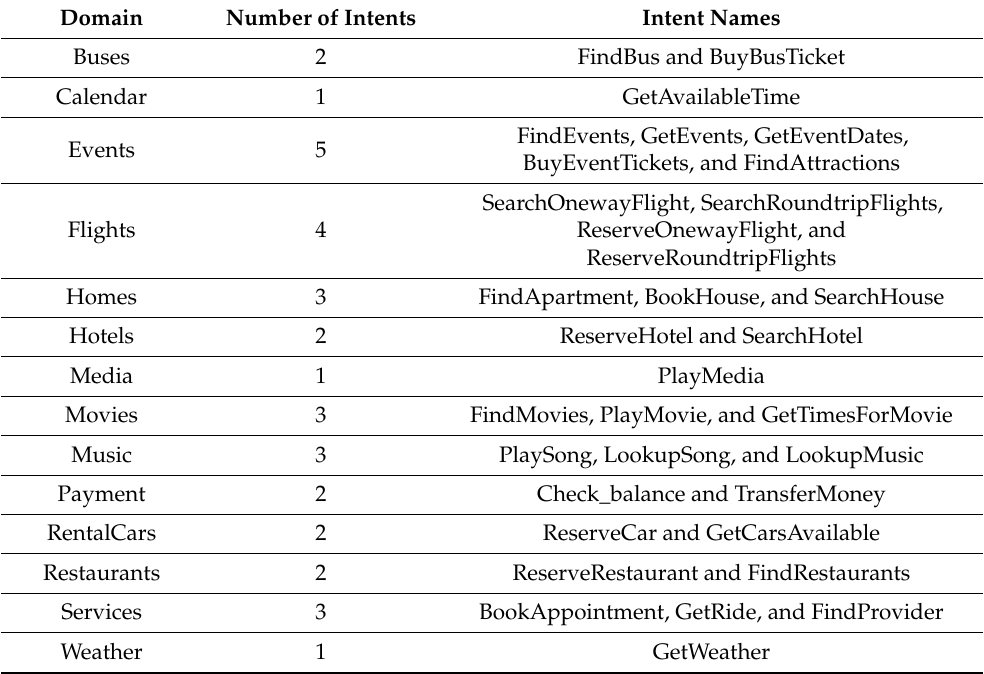
Table 1. Characteristics of the examined